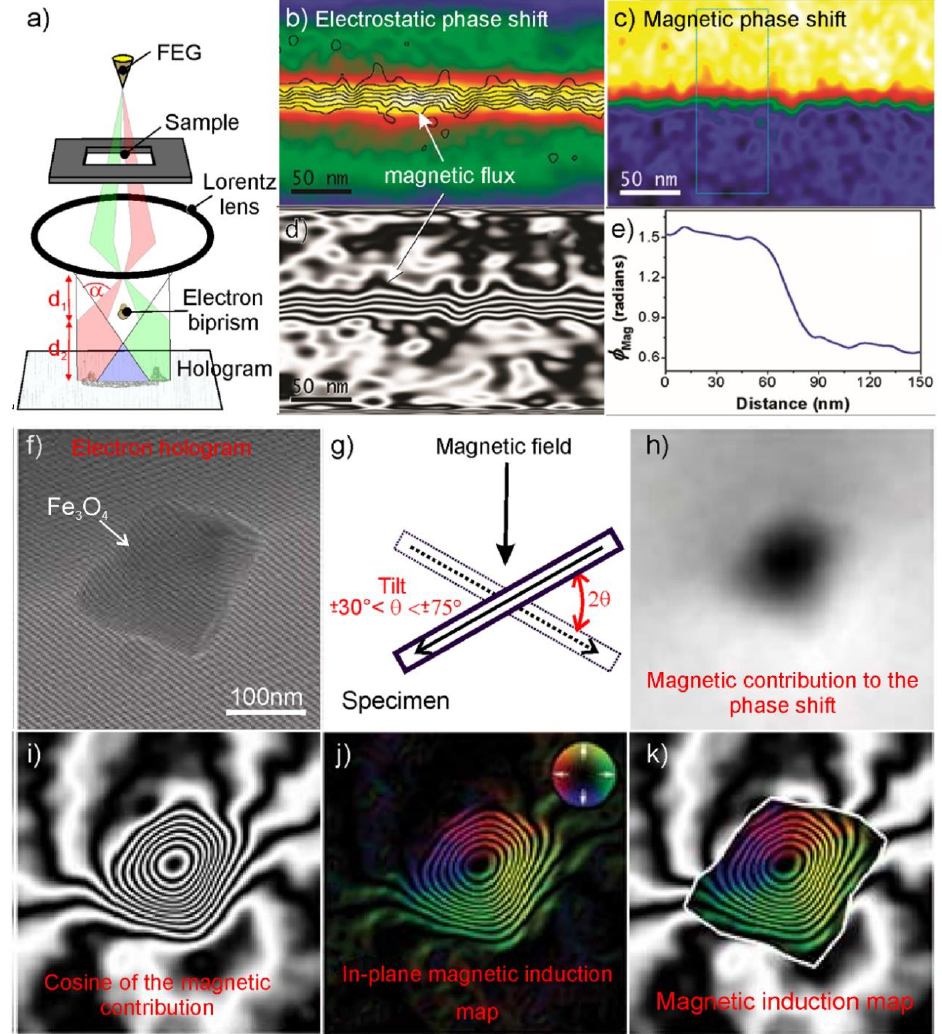
Figure 13. ( a ) Schematic diagram showing interference fringe formation from the overlap of the sample and reference waves by the electron biprism, adapted from [155], published by Wiley, 2010. Electron holography (EH) images of a Co nanowire 9 nm thick and 30 nm long: ( b ) electrostatic and ( c ) magnetic contributions to the electron beam phase shift; the magnetic flux deduced from the magnetic phase image is superimposed over the electrostatic phase shift image; ( d ) the cosine of 38 times the magnetic phase image that allows a better visualization of the magnetic flux within and out of the nanowire; ( e ) phase shift profile extracted from the right part of panel ( d ) where the magnetic induction is constant; ( b – e ) reproduced with permission [156], copyright (2011) by American Chemical Society. ( f ) Electron hologram of a Fe 3 O 4 nanoparticle exposing well-resolved interference fringes; ( g ) representation of the tilting operation to obtain the in-plane magnetization component to the total phase shift; ( h ) magnetic contribution to the total phase shift; ( i ) Cosine of the magnetic contribution to the phase shown in ( g ) to produce contours with a spacing of 0.53 radians; ( j ) direction of the projected in-plane magnetic induction in the Fe 3 O 4 nanoparticle as obtained with the addition of colors; and ( k ) the final magnetic induction map that shows the strength and direction of the magnetic signal in the Fe 3 O 4 nanoparticle and the stray magnetic field. ( f – k ): panels are adapted from [157], published by Wiley,